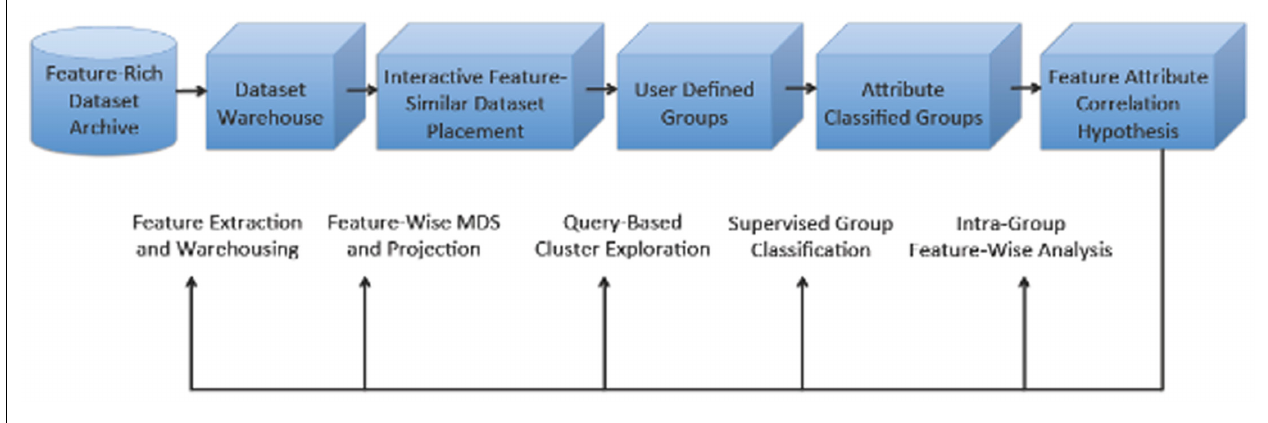
meta-data features, select one or more brain surfaces, and add them to groups which may be assessed with respect to one another to generate hypotheses worthy of new experimentation.This process enables the user to rapidly explore and mine large collections of neuroimaging data for identifying interesting trends across features and